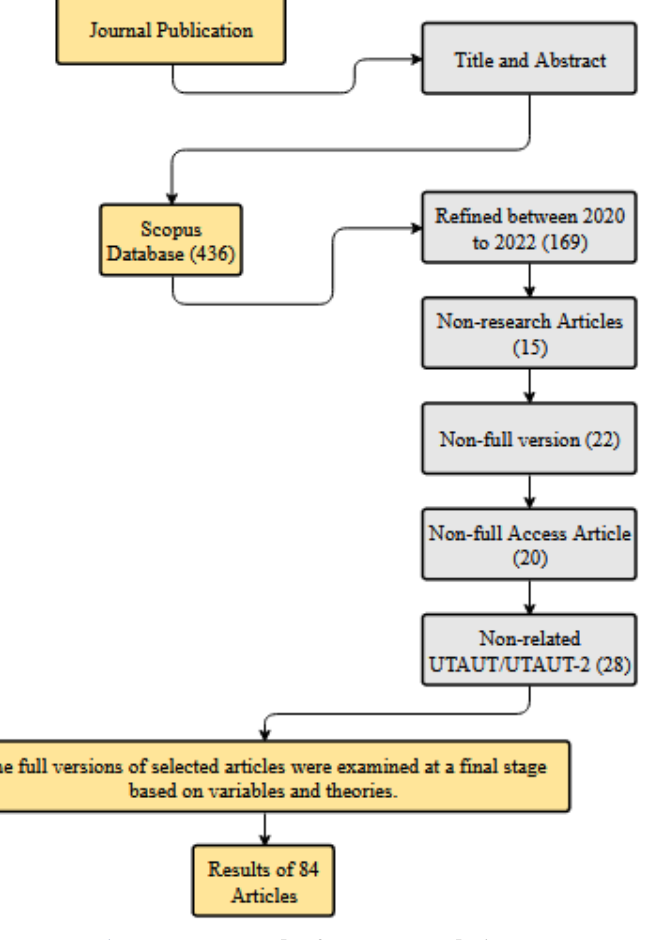
Figure 2. An example of a process